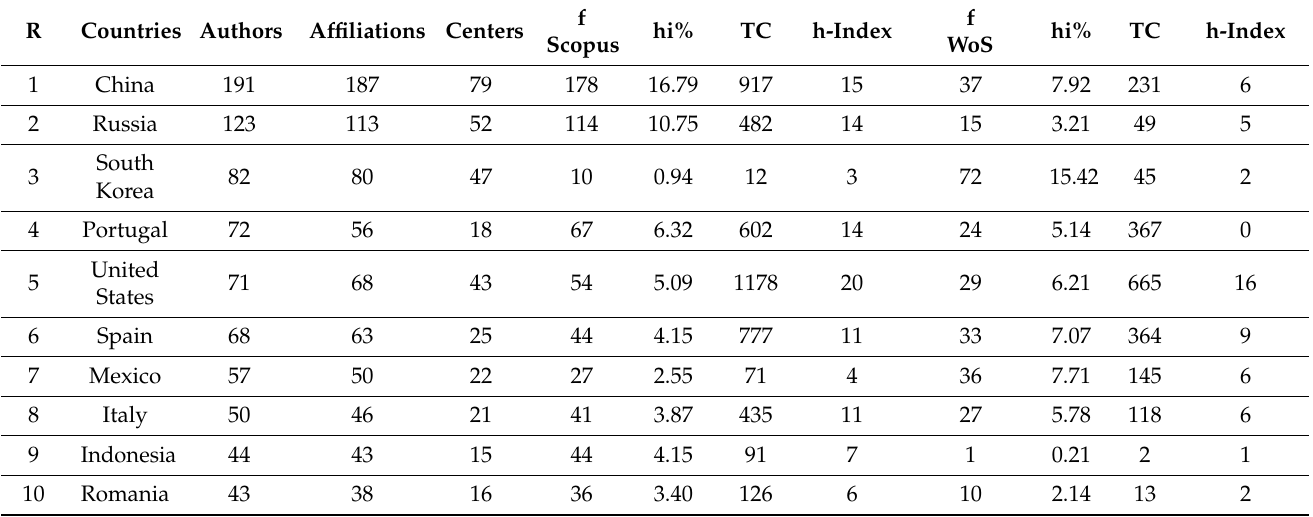
Table 7. Number of centers, authors, and authorships by their country of affiliation.